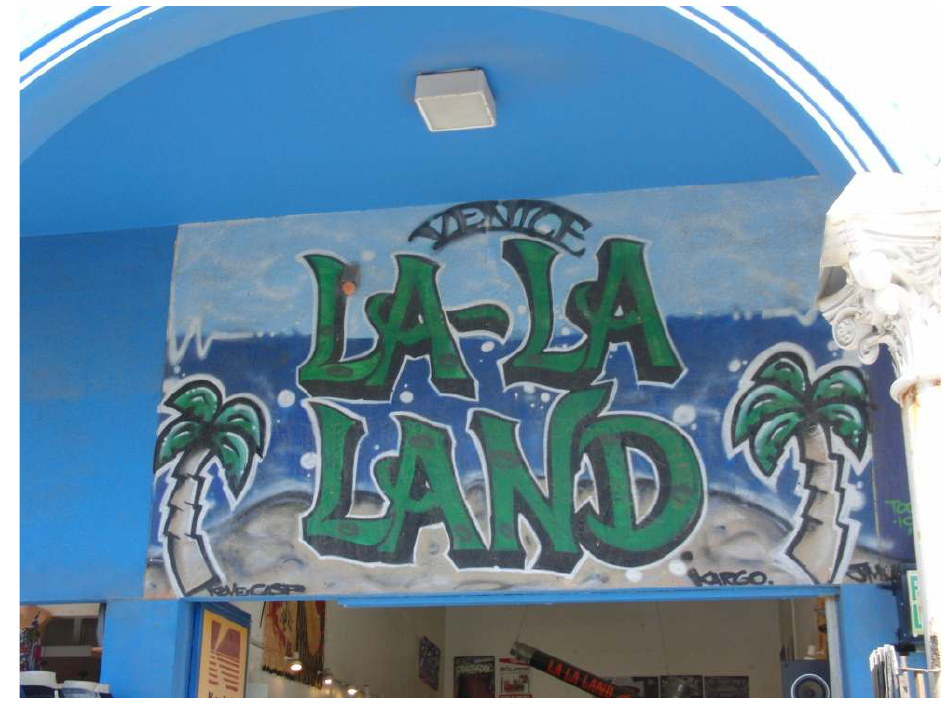
Figure 15: LA-LA LAND, at the Venice Beach